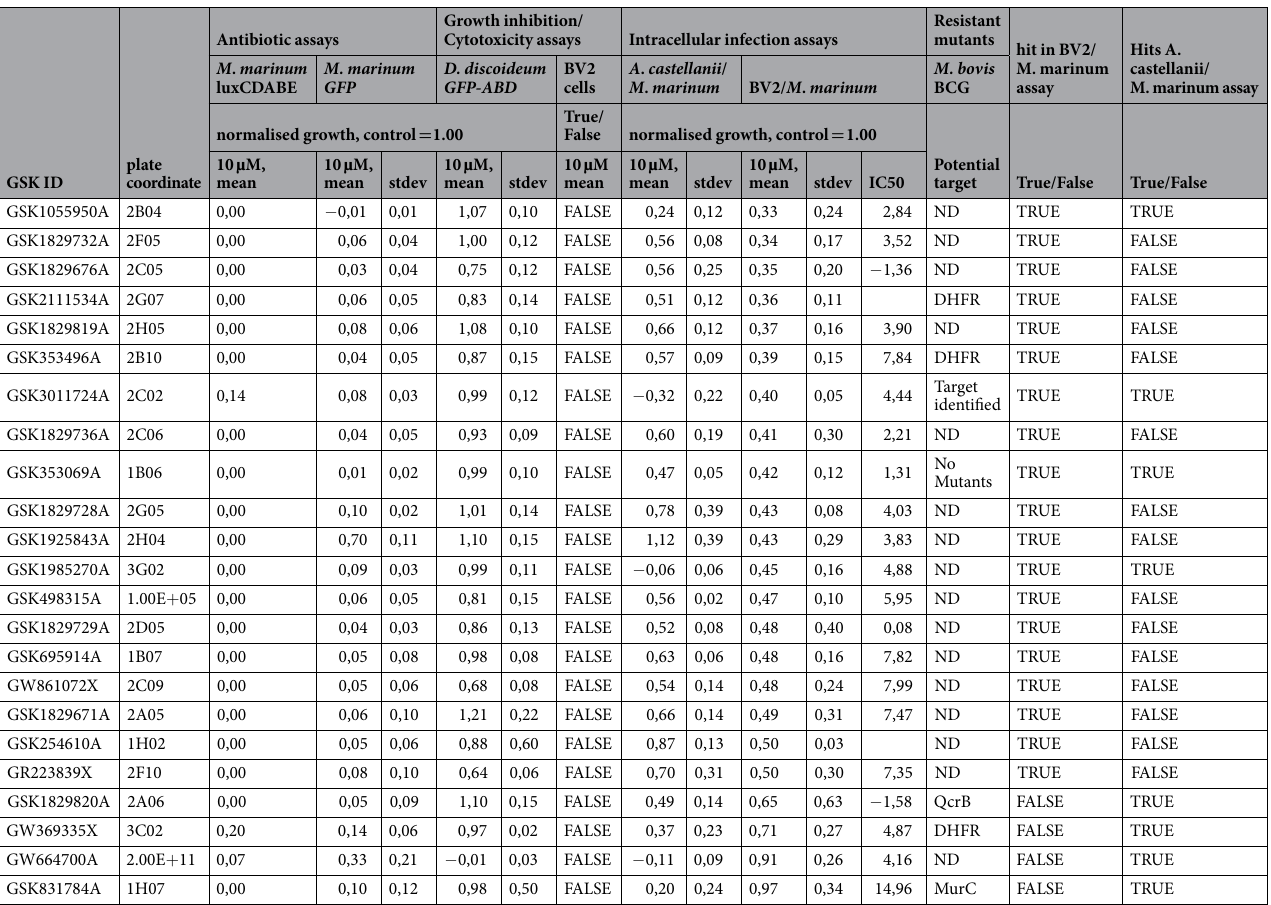
Table 1. Selected hits from Table S1 detected by screening the GSK